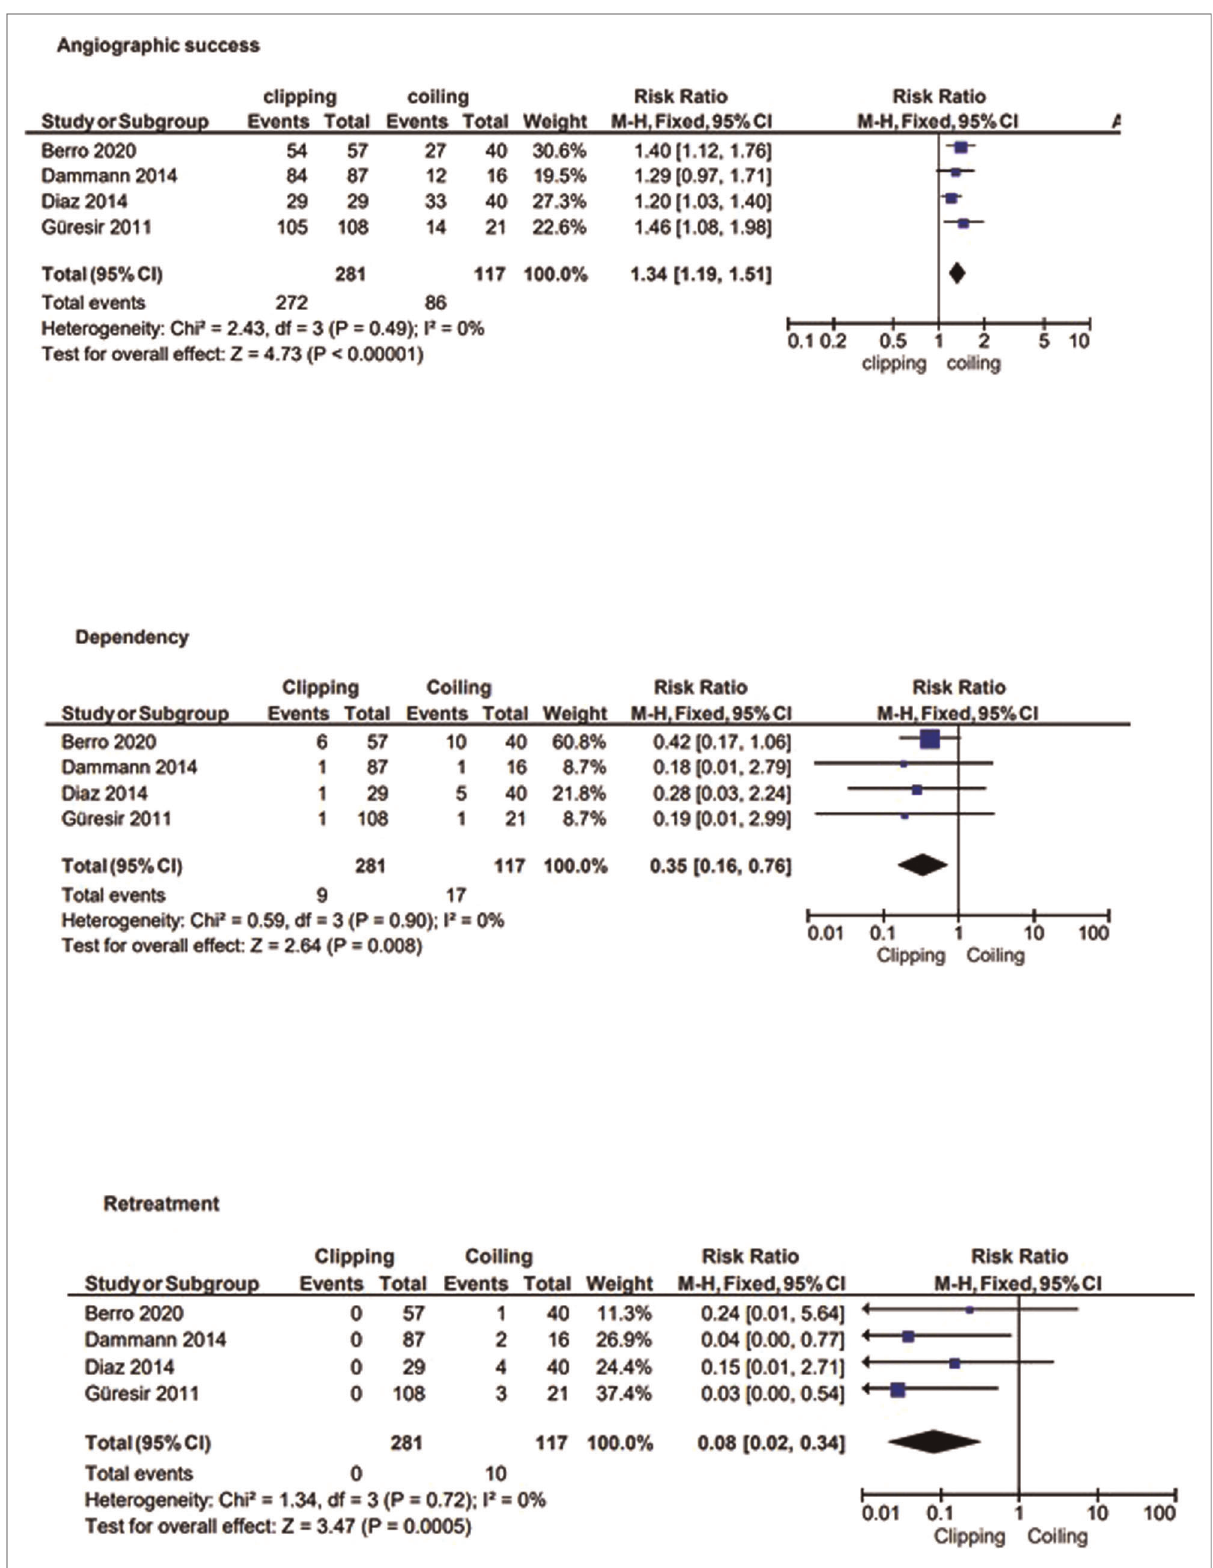
FIGURE 3 Forest plot showing RRs of clipping vs. coiling in terms of angiographic occlusion, fi nal outcome, and